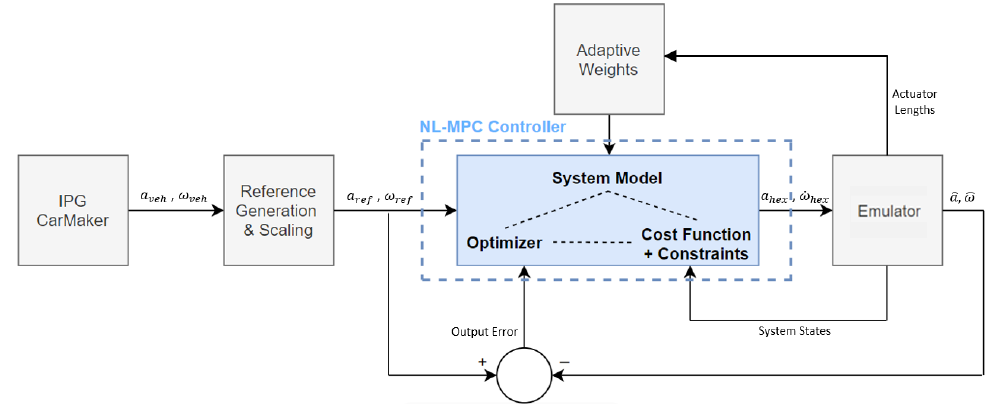
Figure 6. The control scheme used for full-track